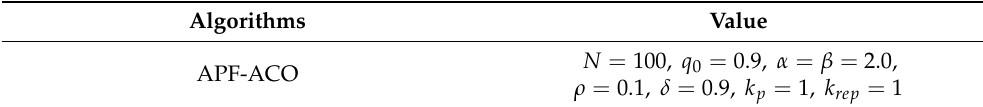
Table 7. Parameter Settings of the System test. Algorithms